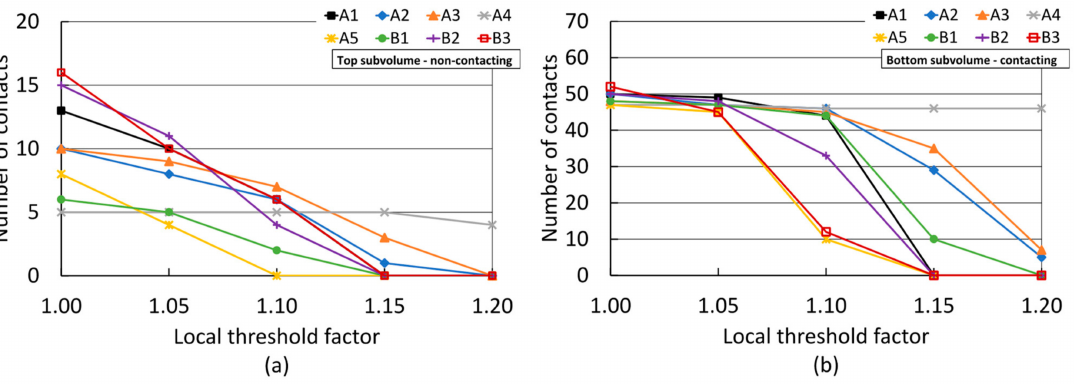
Figure 8. Number of detected contacts between pellet lattices after local refinement using different local threshold factors: ( a ) top subvolume with a prescribed interparticle separation; ( b ) bottom subvolume of full-contacting particles. See Table 1 for scan acquisition details. Data binarised using